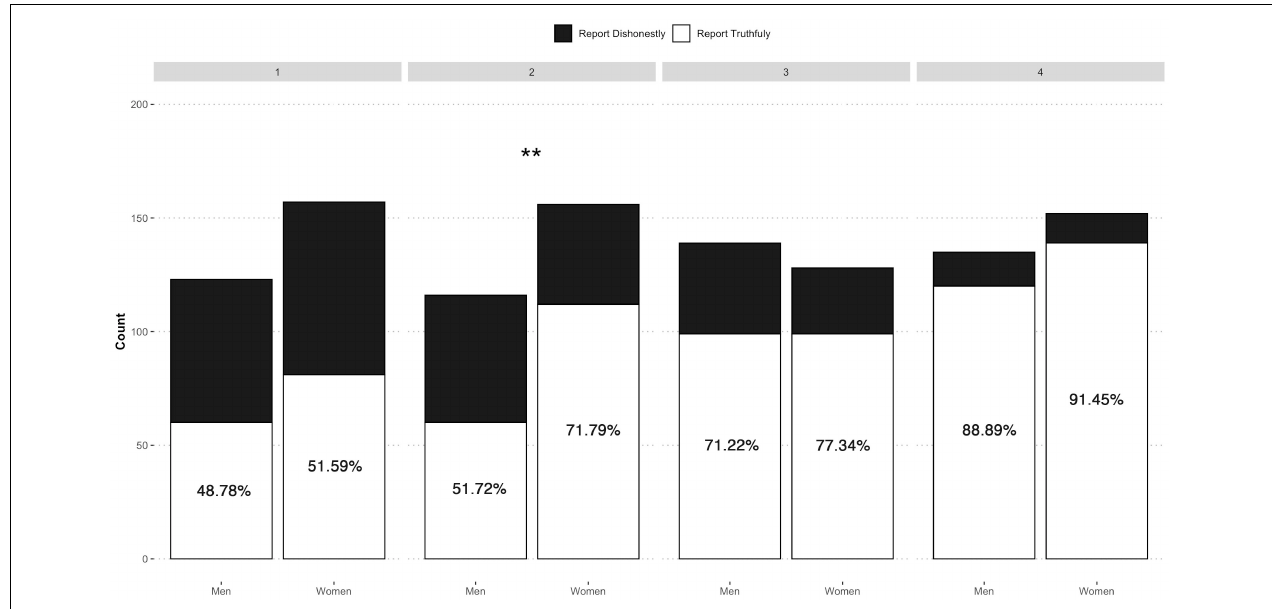
FIGURE 4 | Lucky-honest declared die outcome (men vs. women). Asterisks indicate significance in pairwise proportion comparisons: ** p <